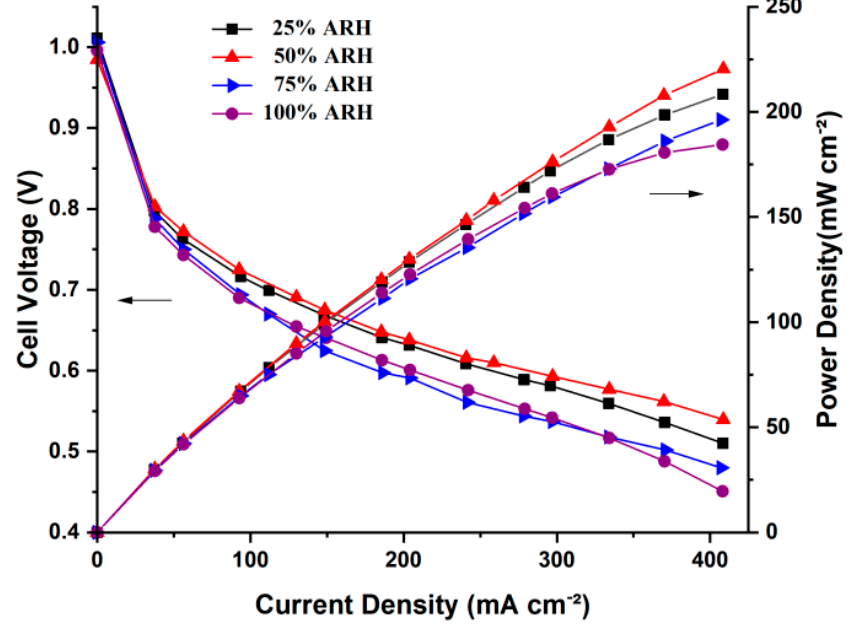
Figure 5. Polarization curves based on experiment results at different ARH (25%, 50%, 75%, 100%).